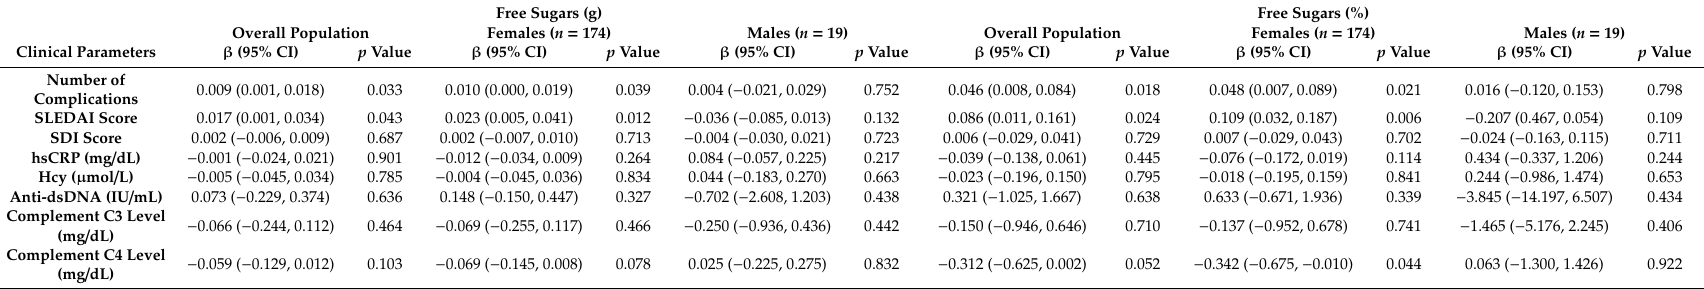
Table 3. Beta estimates and confidence intervals for the association between free sugars intake and clinical disease activity parameters in SLE patients.